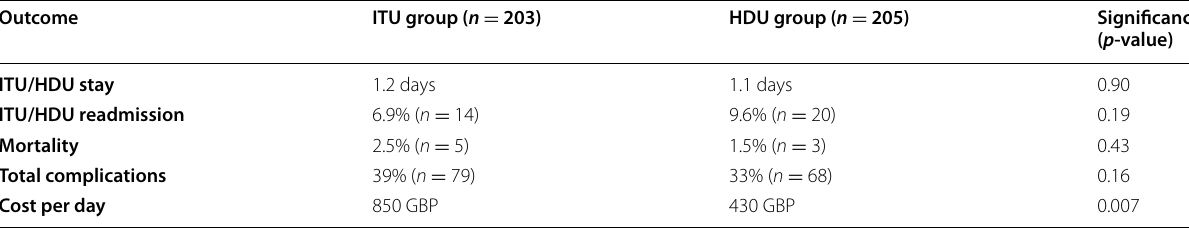
Table 2 Comparison of postoperative outcomes between both groups Outcome ITU group ( n